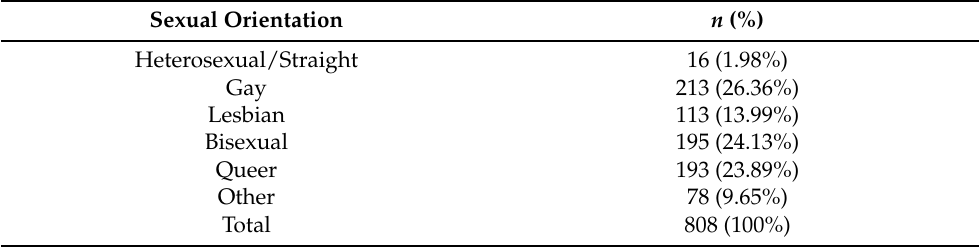
Table 2. Frequency of Sexual